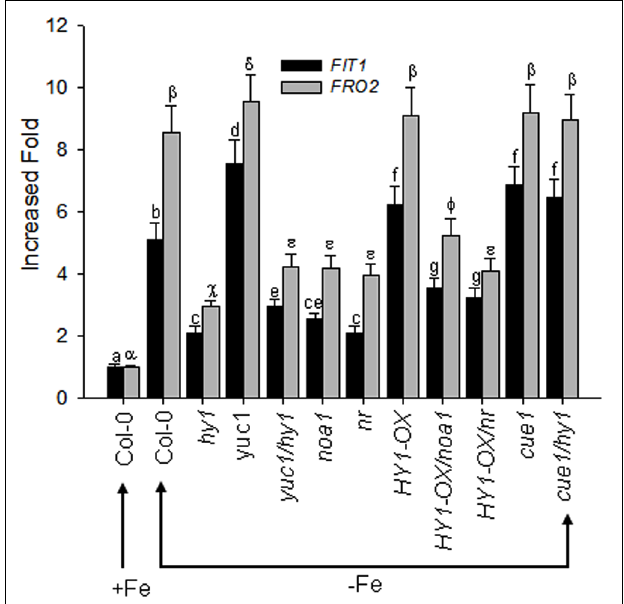
FIGURE 8 | Differential FIT1 and FRO2 expression in CO–, NO–, and auxin-related mutants in response to –Fe stress. Two-week-old wild-type Arabidopsis Col-0 seedlings, CO-related lines ( hy1 and HY1-OX ), auxin-related mutant ( yuc1 ) and NO-related mutants ( cue1, noa1, nr ), and double mutants ( yuc1/hy1, HY1-OX/nr, HY1-OX/noa1, cue1/hy1) were transferred to –Fe media. The FIT1 and FRO2 gene expression in the roots were analyzed by RT-PCR after 24 h of treatment. Tubulin gene expression was used as a control. Data are the means ± SD ( n = 9), and bars with different letters are significantly different at p < 0.05 (Tukey’s